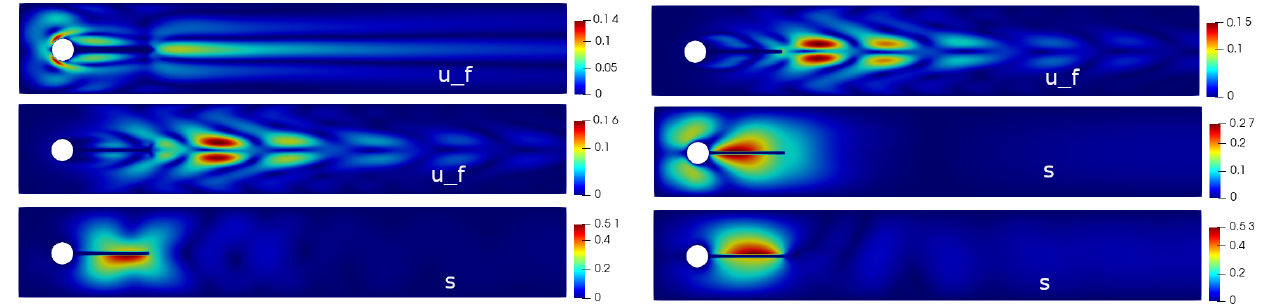
Figure 4. The first POD modes for the fluid velocity u f and for the supremizer s (magnitude)